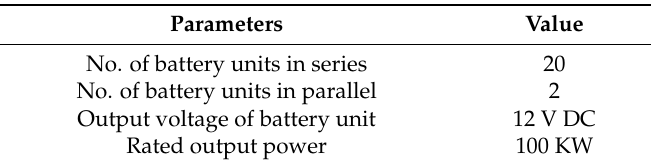
Table A4. Battery specifications.